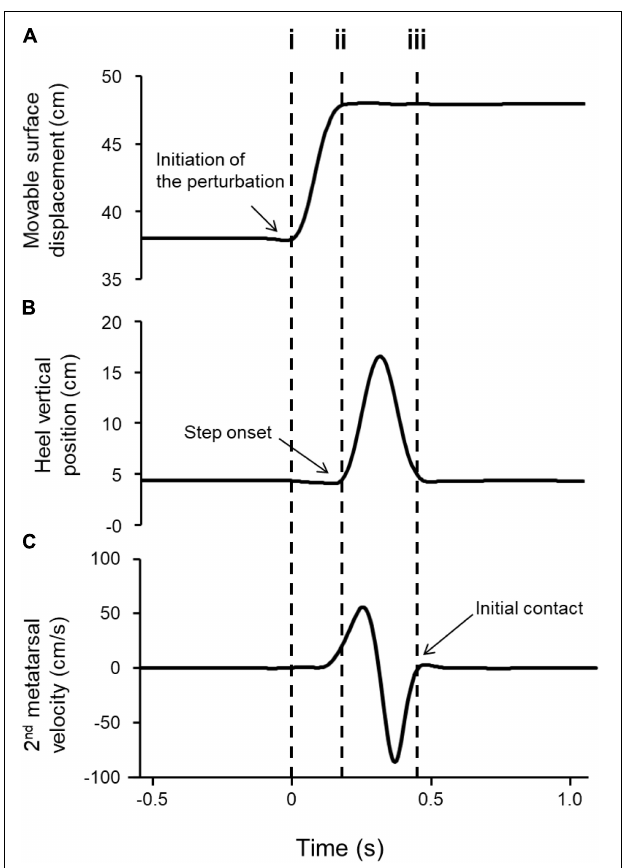
FIGURE 1 | Representative kinematic profiles of the horizontally movable platform and step leg during backward stepping. (A) Displacement of the movable platform in the antero-posterior direction, (B) heel position in the sagittal plane, and (C) vertical velocity of the head of the second metatarsal. The dashed vertical lines indicate (i) movable surface motion onset, (ii) step onset, and (iii) initial contact. Step time is defined as the period between step onset (ii) and initial contact (iii).